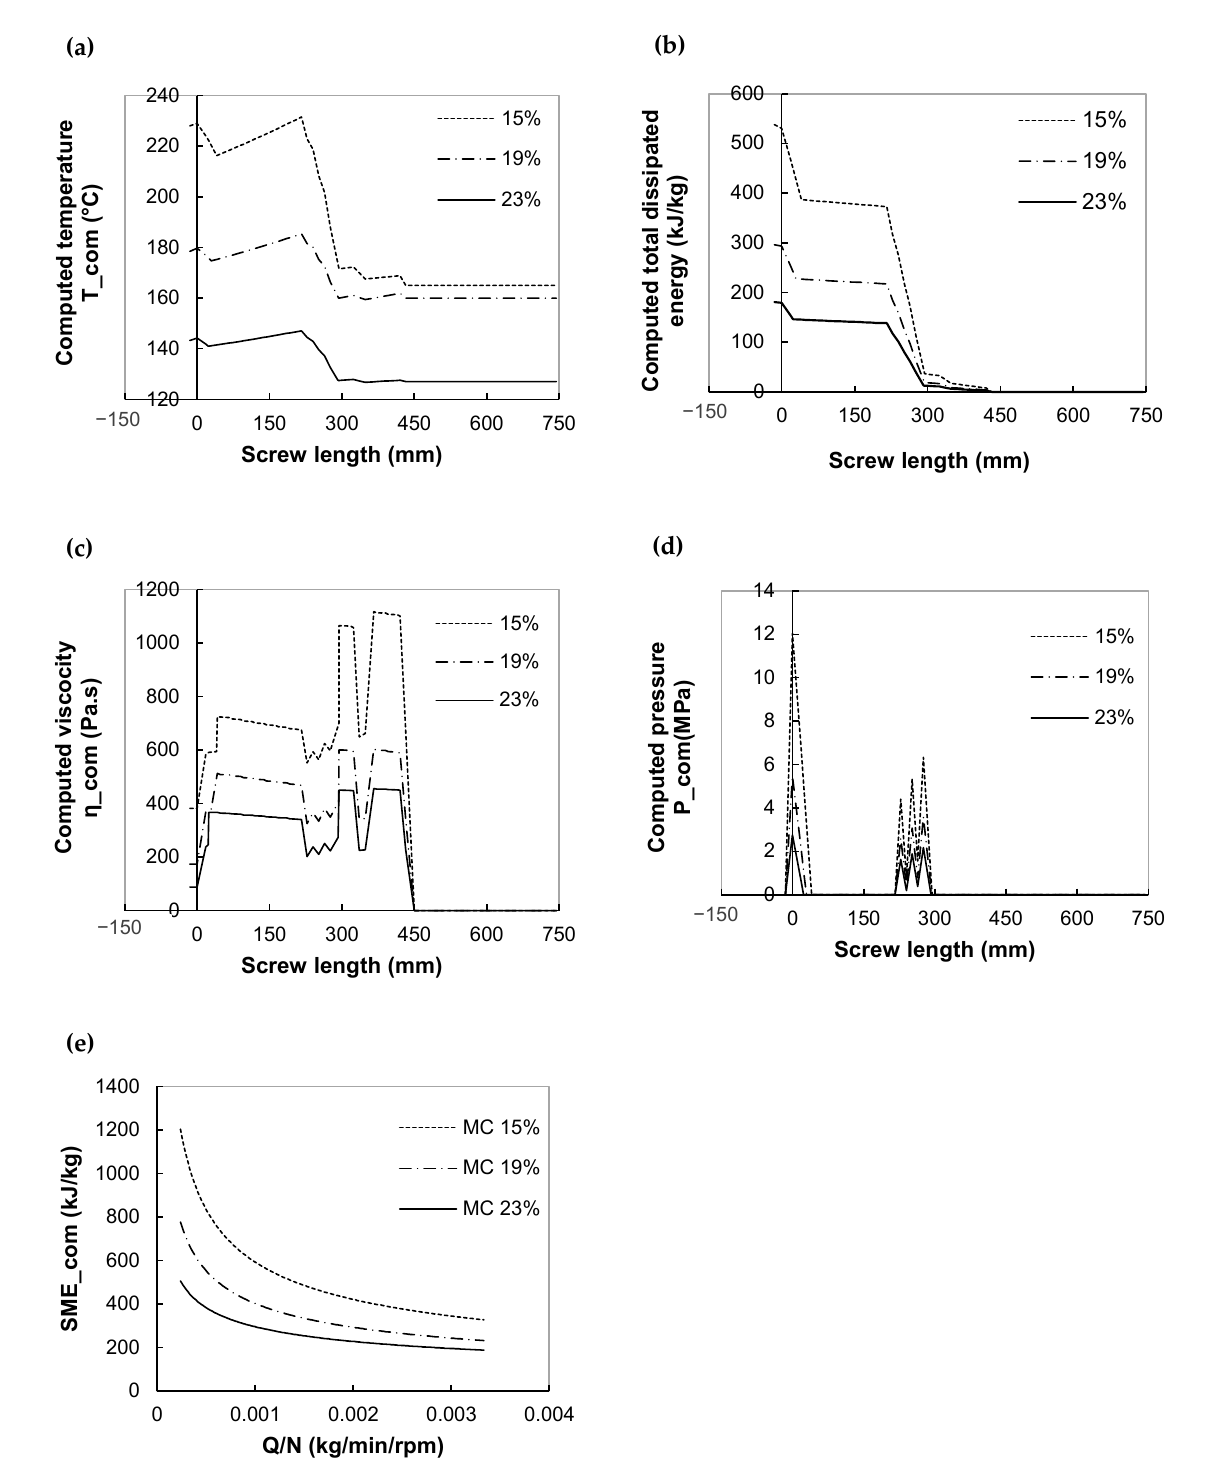
Figure 3. Effect of moisture content on computed temperature ( a ), total dissipated energy ( b ), viscosity ( c ), and pressure ( d ) along the screw and variation of SME with filling ratio (Q/N) ( e ). Study case: breakfast cereal: CB formulation. For ( a – d ), processing conditions: Q = 20 kg/h, N = 500 rpm, Tb = 90 ◦